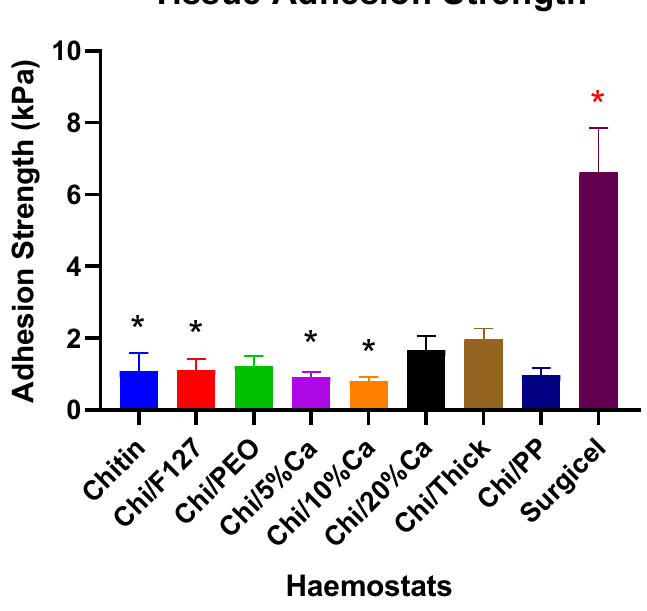
Figure 9. Tissue adhesion strength of modified and non-modified beta-chitin patches and Surgicel. *p < 0.05, significantly lower compared to Chi/Thick. *p < 0.05, significantly higher compared to modified and non- modified beta-chitin patch analysed by Kruskal–Wallis one-way ANOVA with Dunn’s test, n =